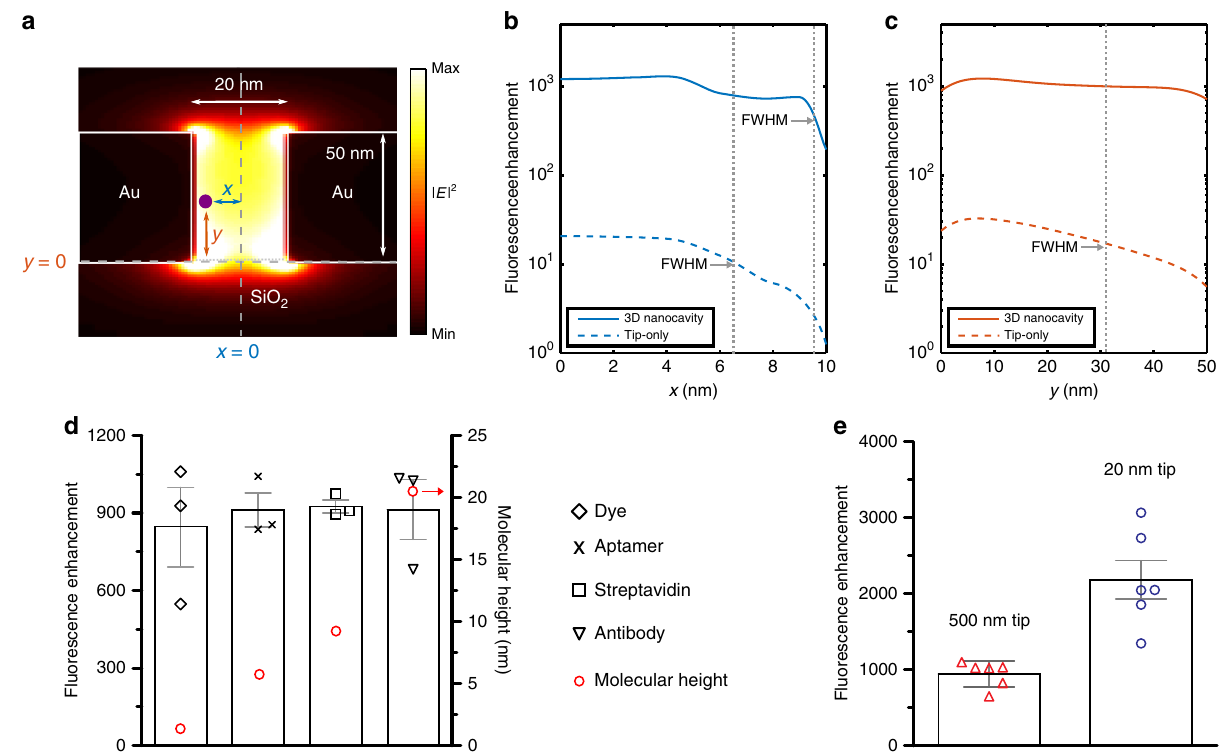
Fig. 4 Overcoming electromagnetic fi eld decay for molecular analysis. a Cross-section of the tip at the end of taper showing EM fi eld intensity and placement of a fl uorophore with distance along the x and y axis for a 500 nm long tip. Variations in net fl uorescence enhancement, calculated as a product between the EM enhancement and quantum yield gain, of the 3D nanocavity (solid line) and tip-only structure (dashed line) as a function of molecular position along the b x - and c y -axes. Metal-induced quenching effects are visible near the metallic sidewalls of both structures. The 3D nanocavity shows uniform fl uorescence enhancement for about 95.5% (FWHM) of the x -axis and 100% of the y -axis. d Experimentally obtained enhancement